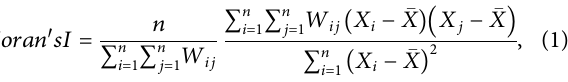
Frontiers in Environmental Science |